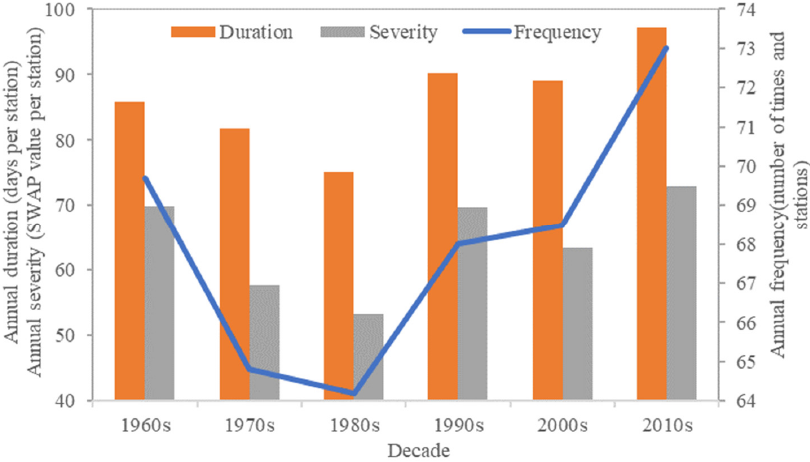
Figure 3. Decadal variation of annual duration, annual severity, and annual frequency of ordinary drought events. drought